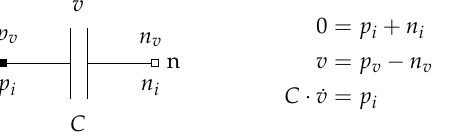
Figure 4. Equation-based model of a capacitor with parameter C , state v , connectors p , n with potential variables p v , n v (electrical potentials), and flow variables p i , n i (electric